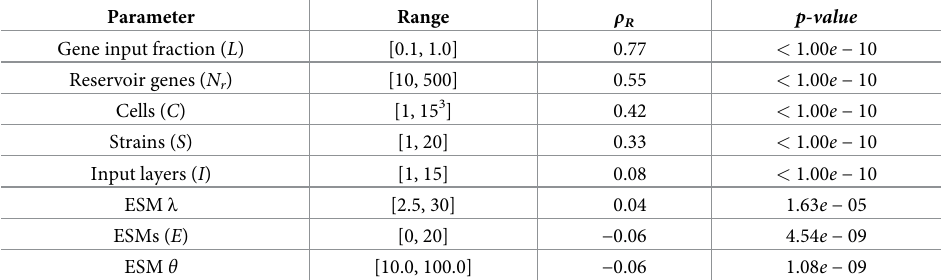
Table 1. Sensitivity analysis results, including parameter range, rank correlation ( ρ earlier works, L and N r have strong correlation with reservoir accuracy. These results add C and S to the set of parame- ters that are strongly correlated with accuracy. The number of input layers, I , the number of ESMs, λ , and θ all have noticeably lower